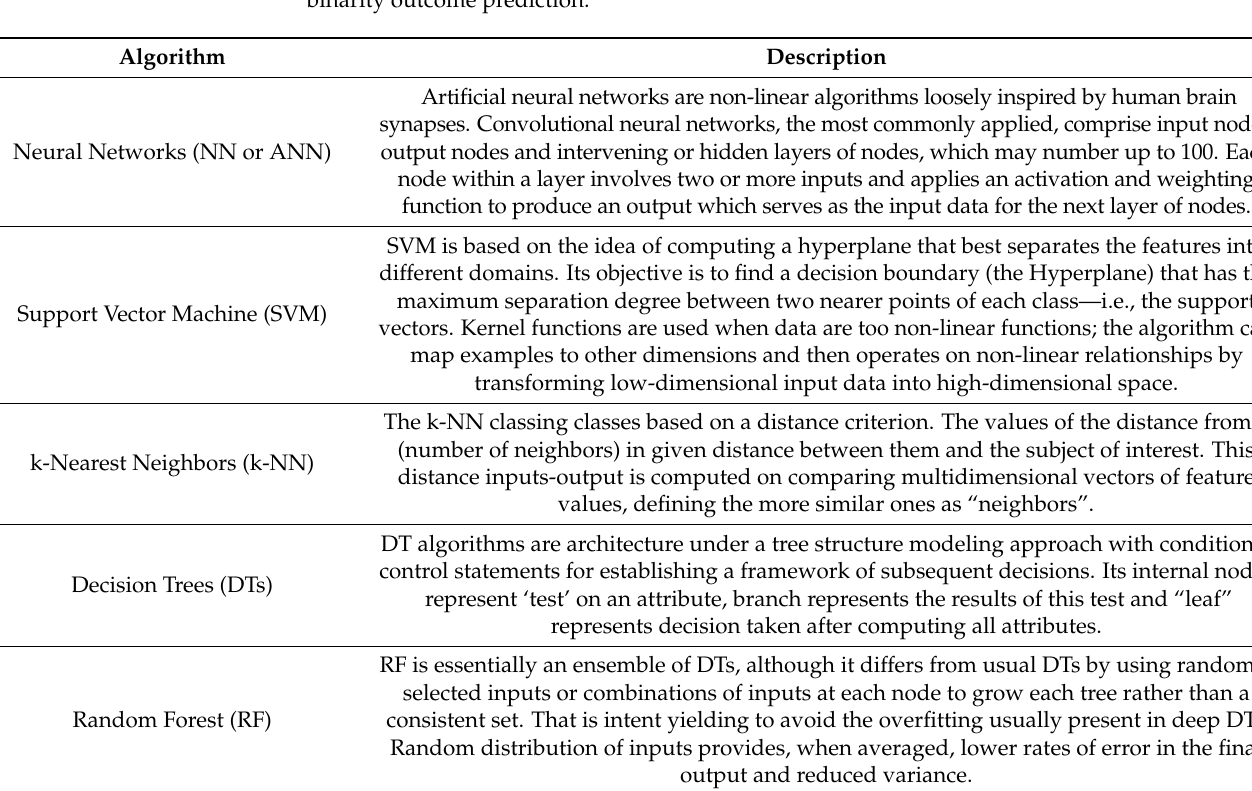
Table 2. Examples and conceptualization of most utilized machine learning-based algorithms for binarity outcome